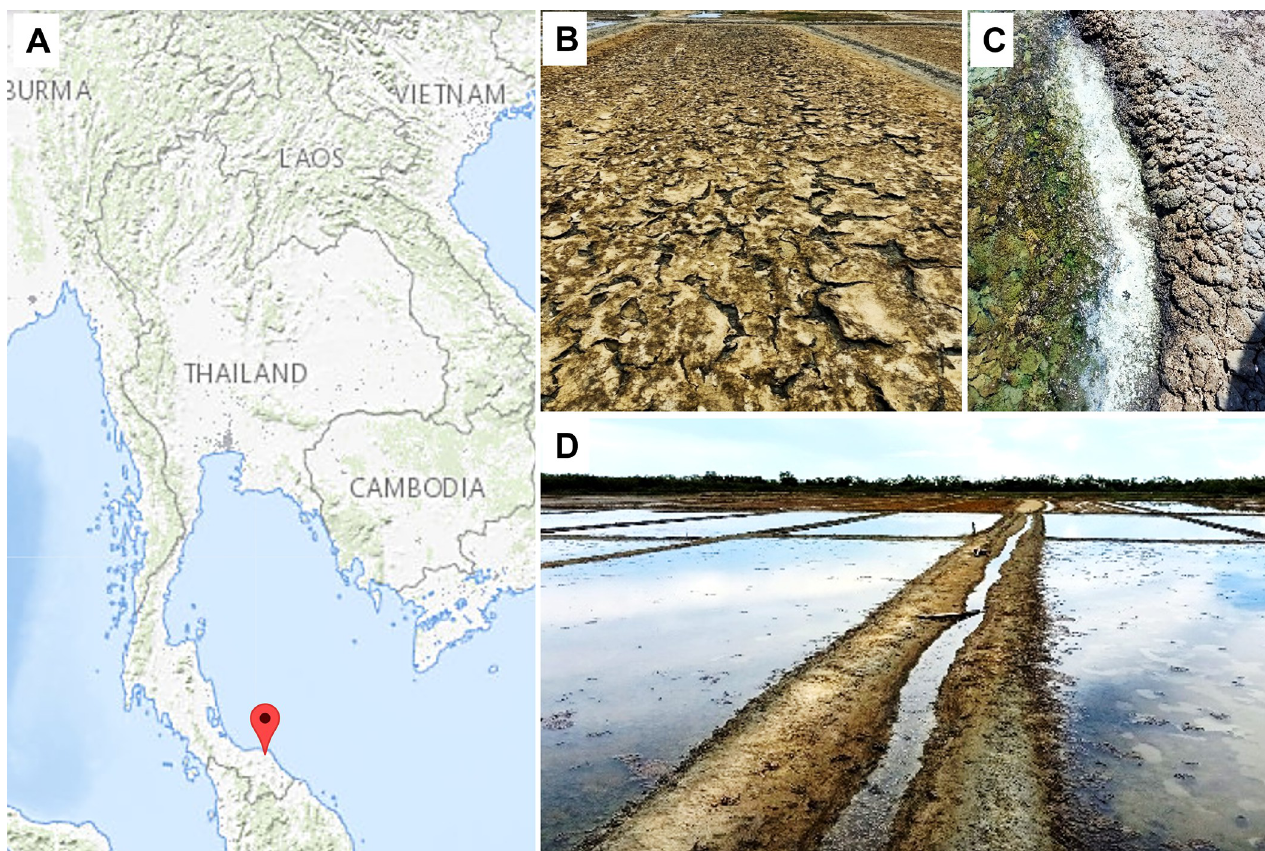
Fig 1. Sampling sites. A) Geographic location of the sampling sites (USGS National Map Viewer (http://viewer.nationalmap.gov/viewer/)). B-D) Characteristics of the sampling sites and neighboring locations at Ban Bana district, Pattani Province, Thailand.